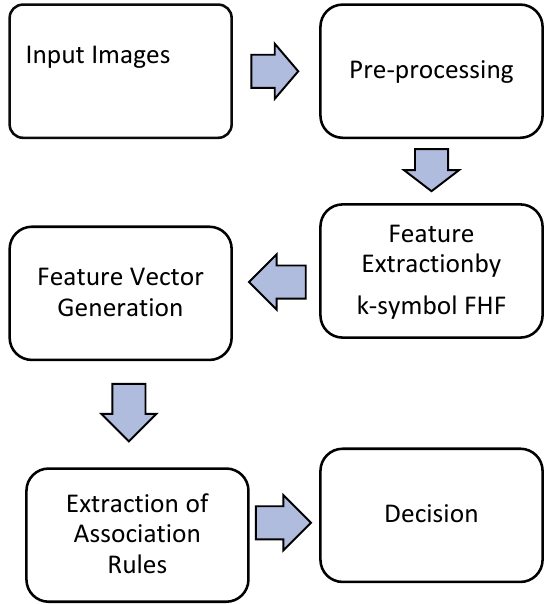
Figure 2. The steps for the proposed DIS in the testing phase.